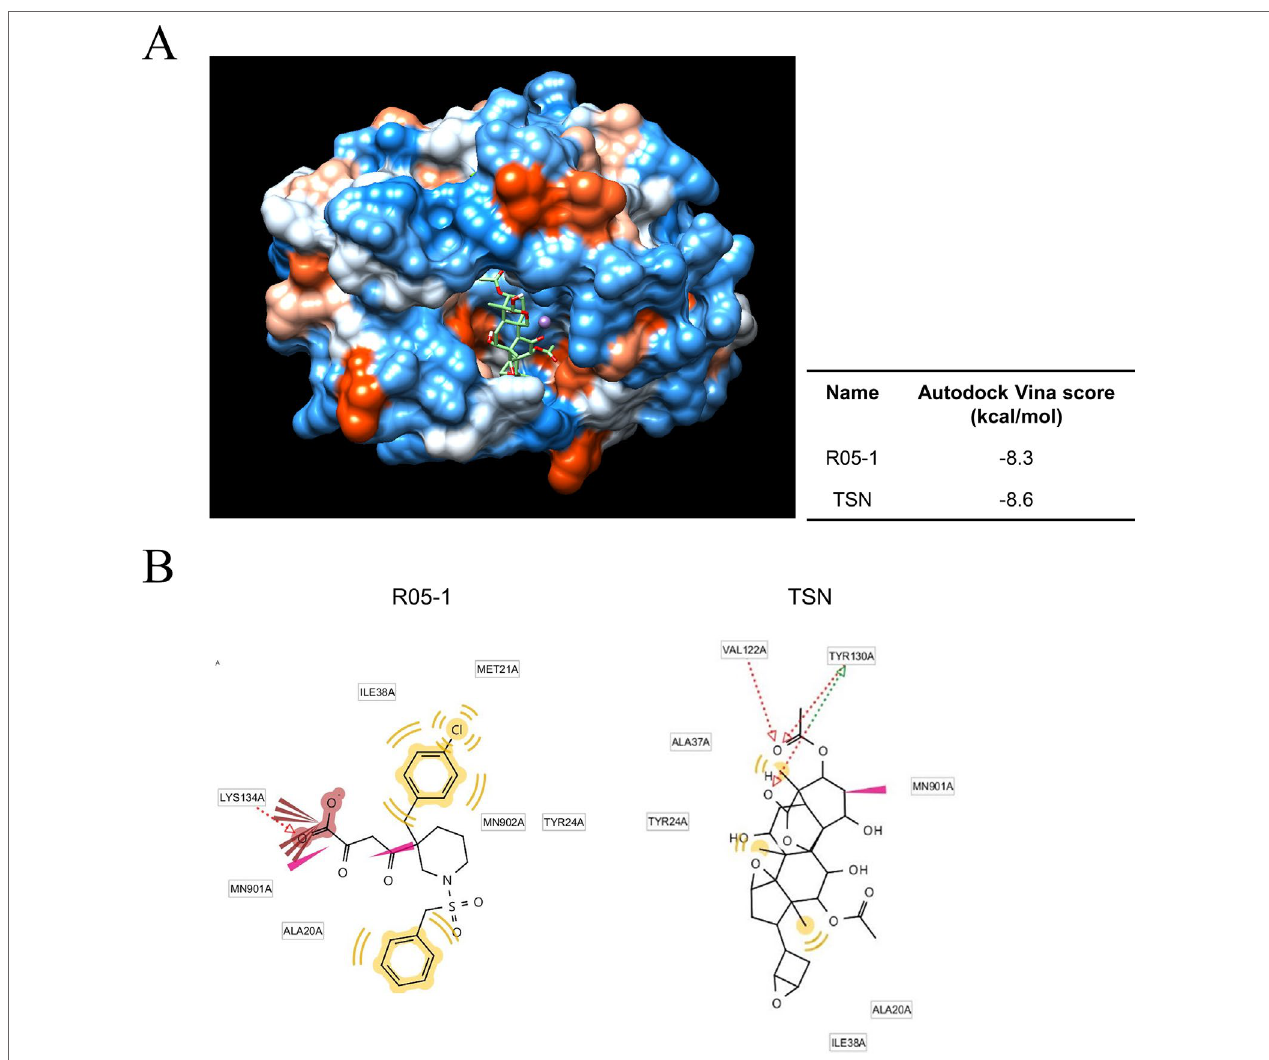
FIGURE 7 | Docking and binding simulations showing that TSN can occupy the active site within the PA protein. (A) Computational structure prediction for docking simulation between TSN and the N-terminal domains of PA (PA-Nter) protein of influenza virus pH1N1. The small tables indicate the predicted docking score for TSN and the positive control R05-01 with the PA protein. (B) The binding sites of TSN and the positive control R05-01 on the PA-Nter domain are